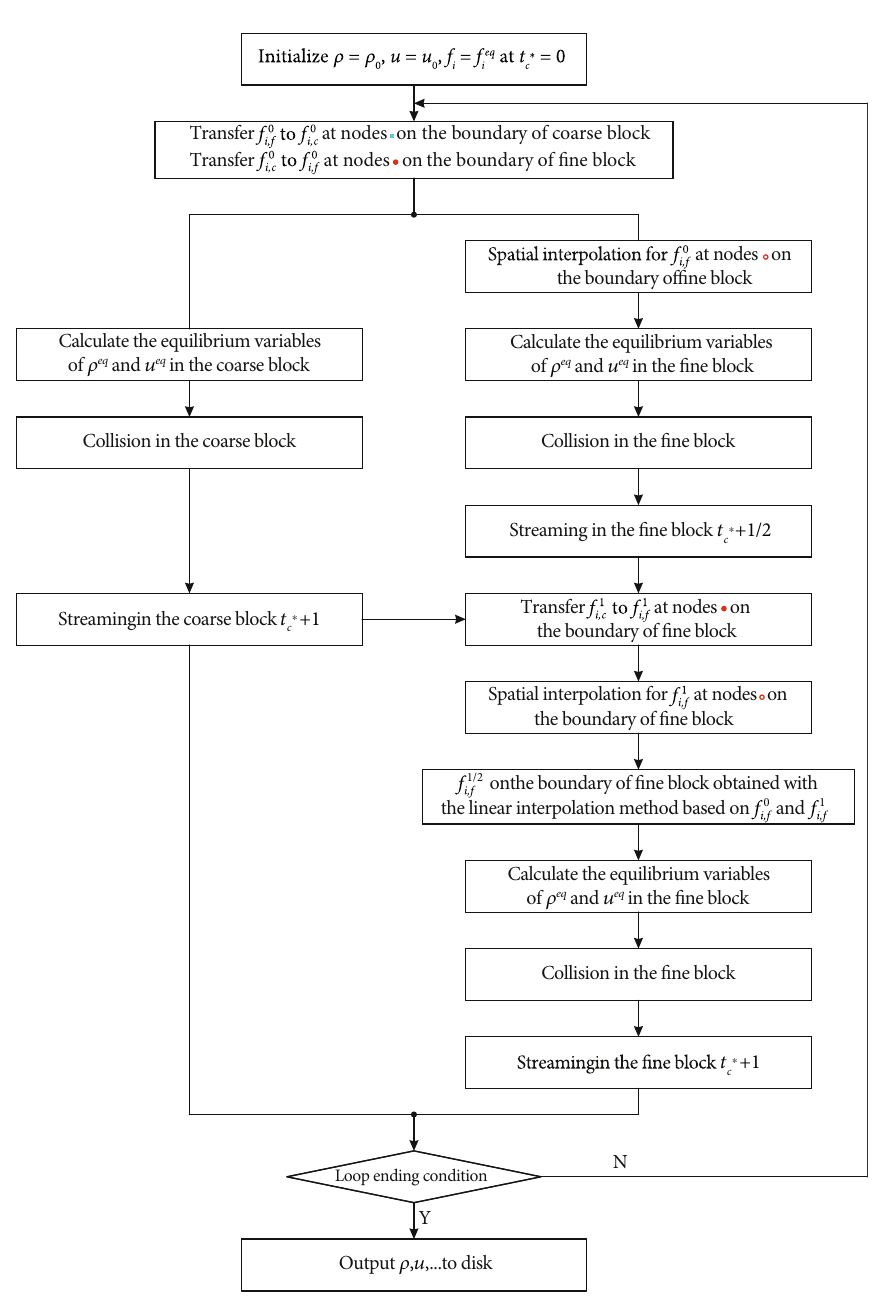
Figure 4: Multigrid REV-LBM program fl